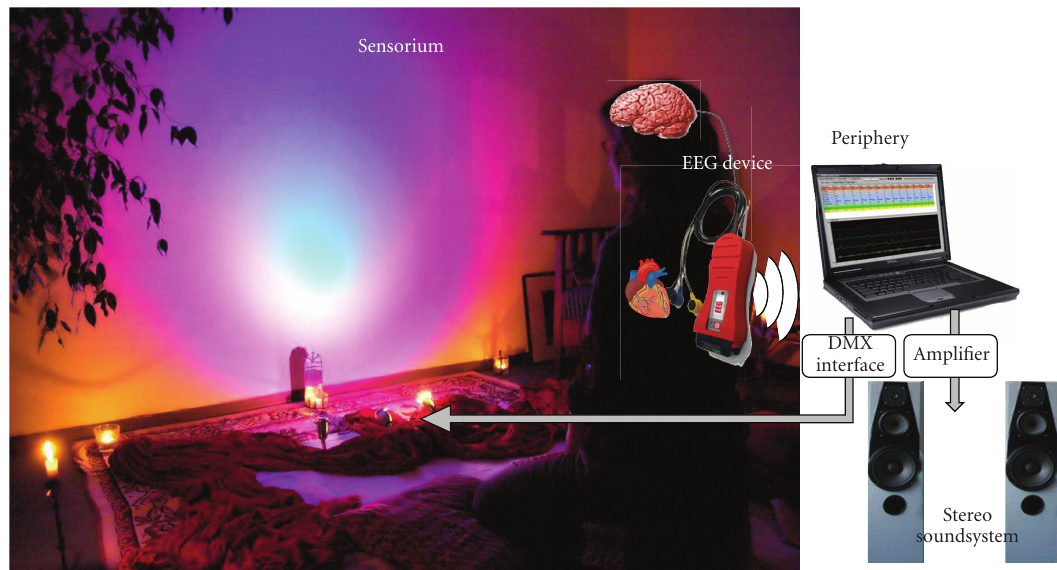
Figure 3: Participants sitting inside the Sensorium watching and listening to their own physiological signals. The technology and the experimenter were placed to the remote periphery.